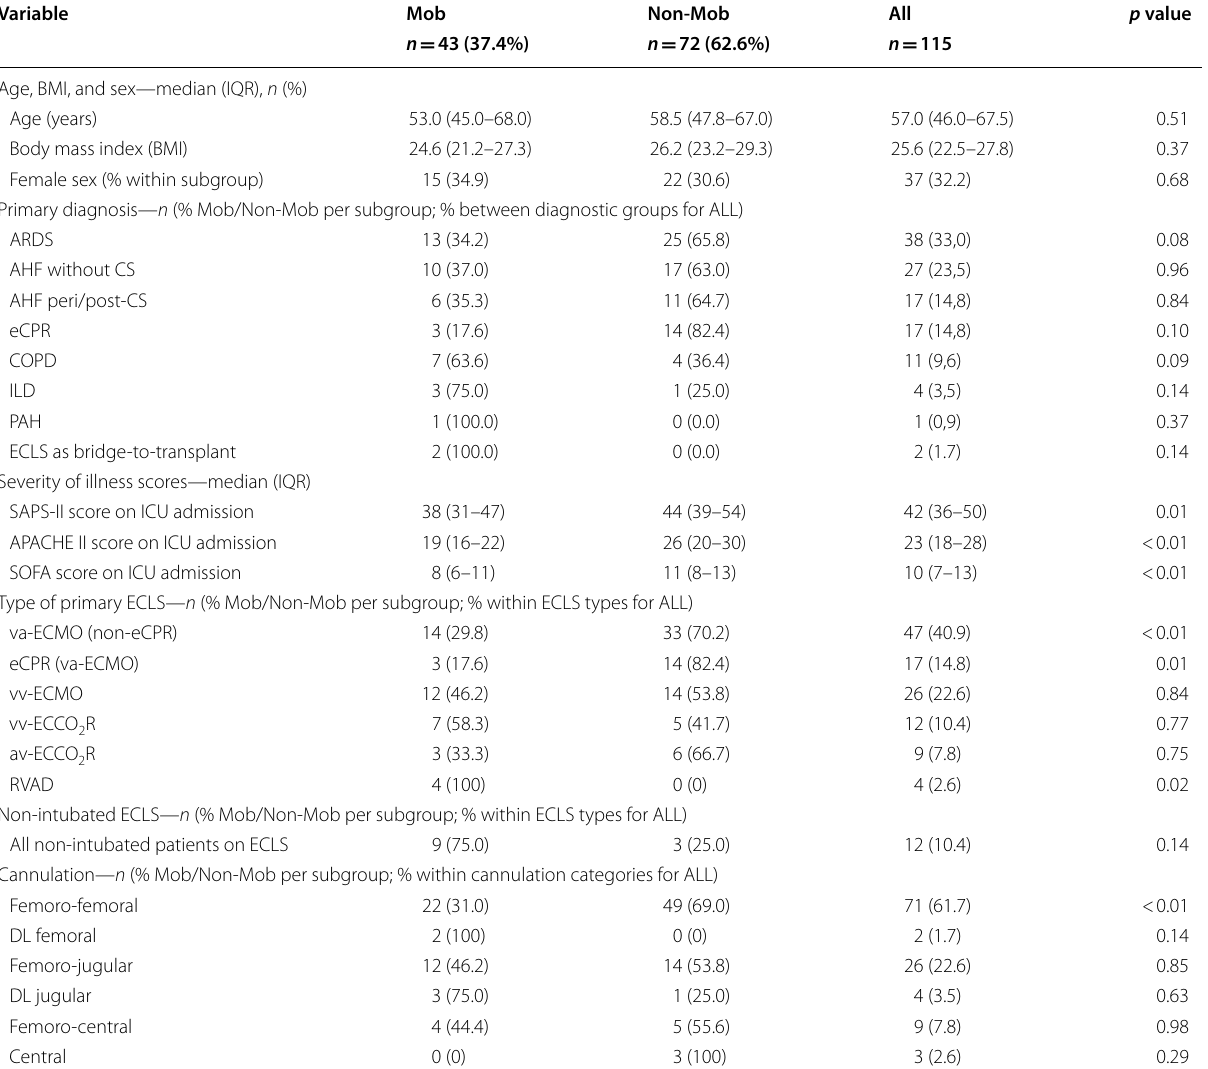
Table 2 Baseline demographics, diagnostic categories, severity of illness scores, type of primary ECLS, non-intubated patients, cannulation configuration according to level of